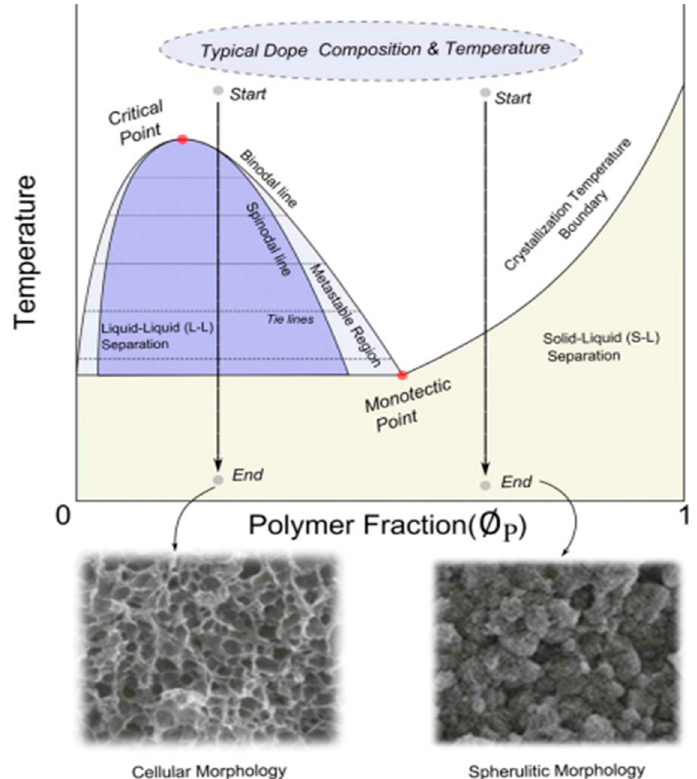
Figure 3. Phase diagram of the TIPS process, adapted from [63] .